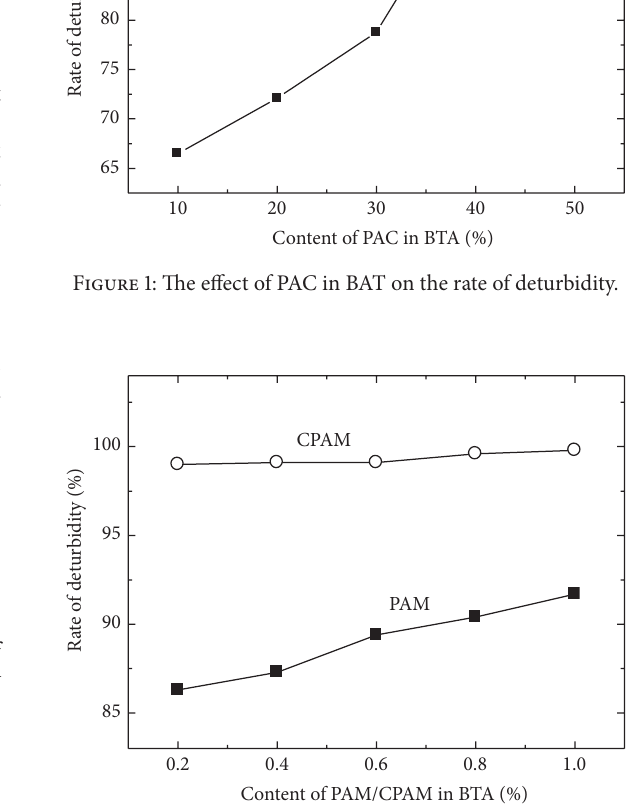
Figure 2: The effects of PAM/CPAM in BAT on the rate of detur-